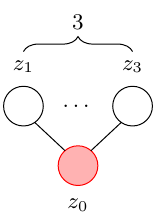
Figure 7 . P (3) quiver with [1 3 ]